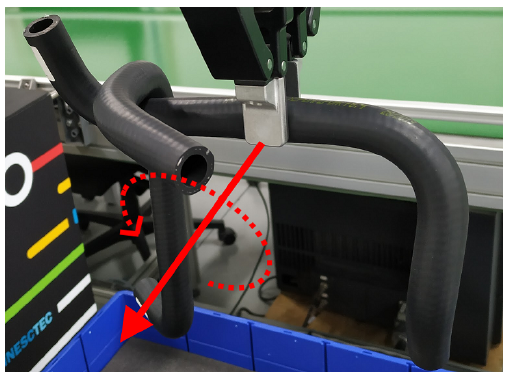
Figure 6. Visual representation of the torque